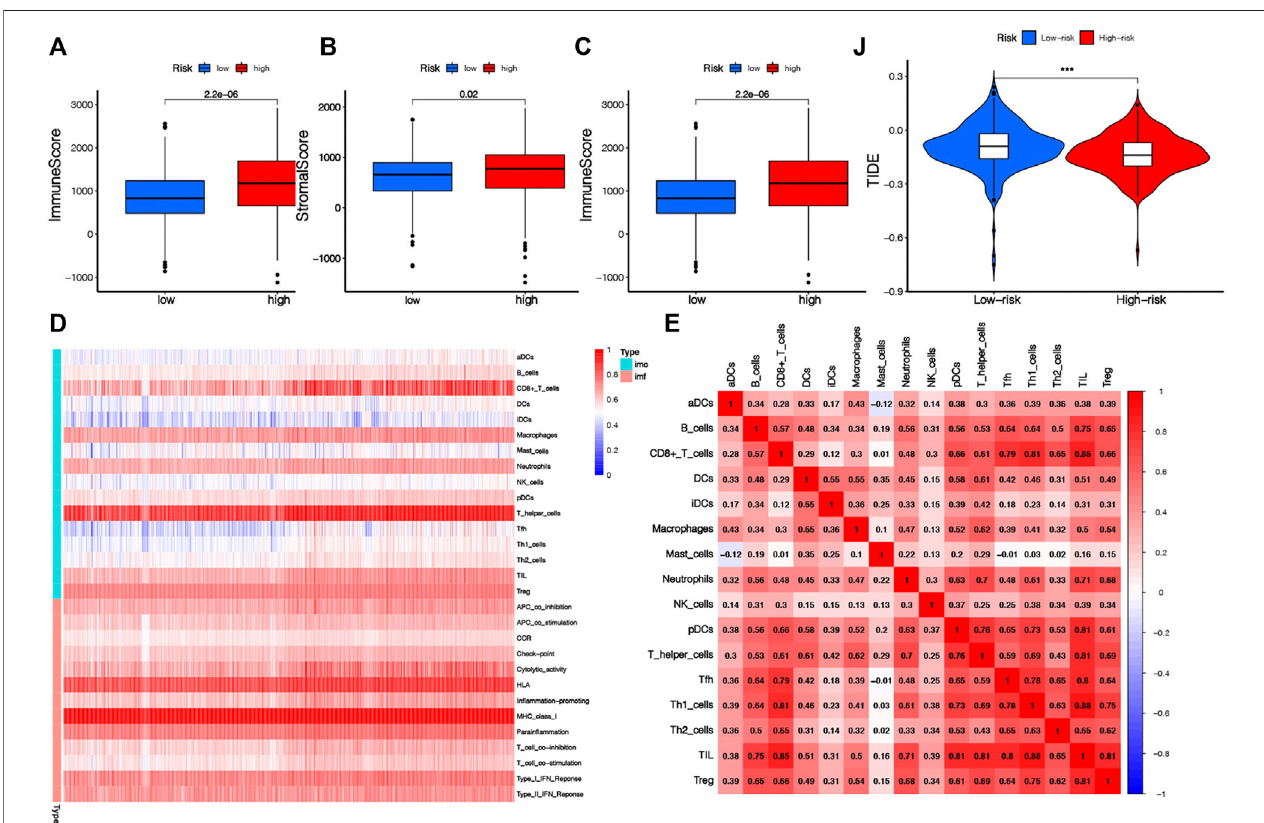
( Figure 12A ; Supplementary Table S4 ). Afterwards,